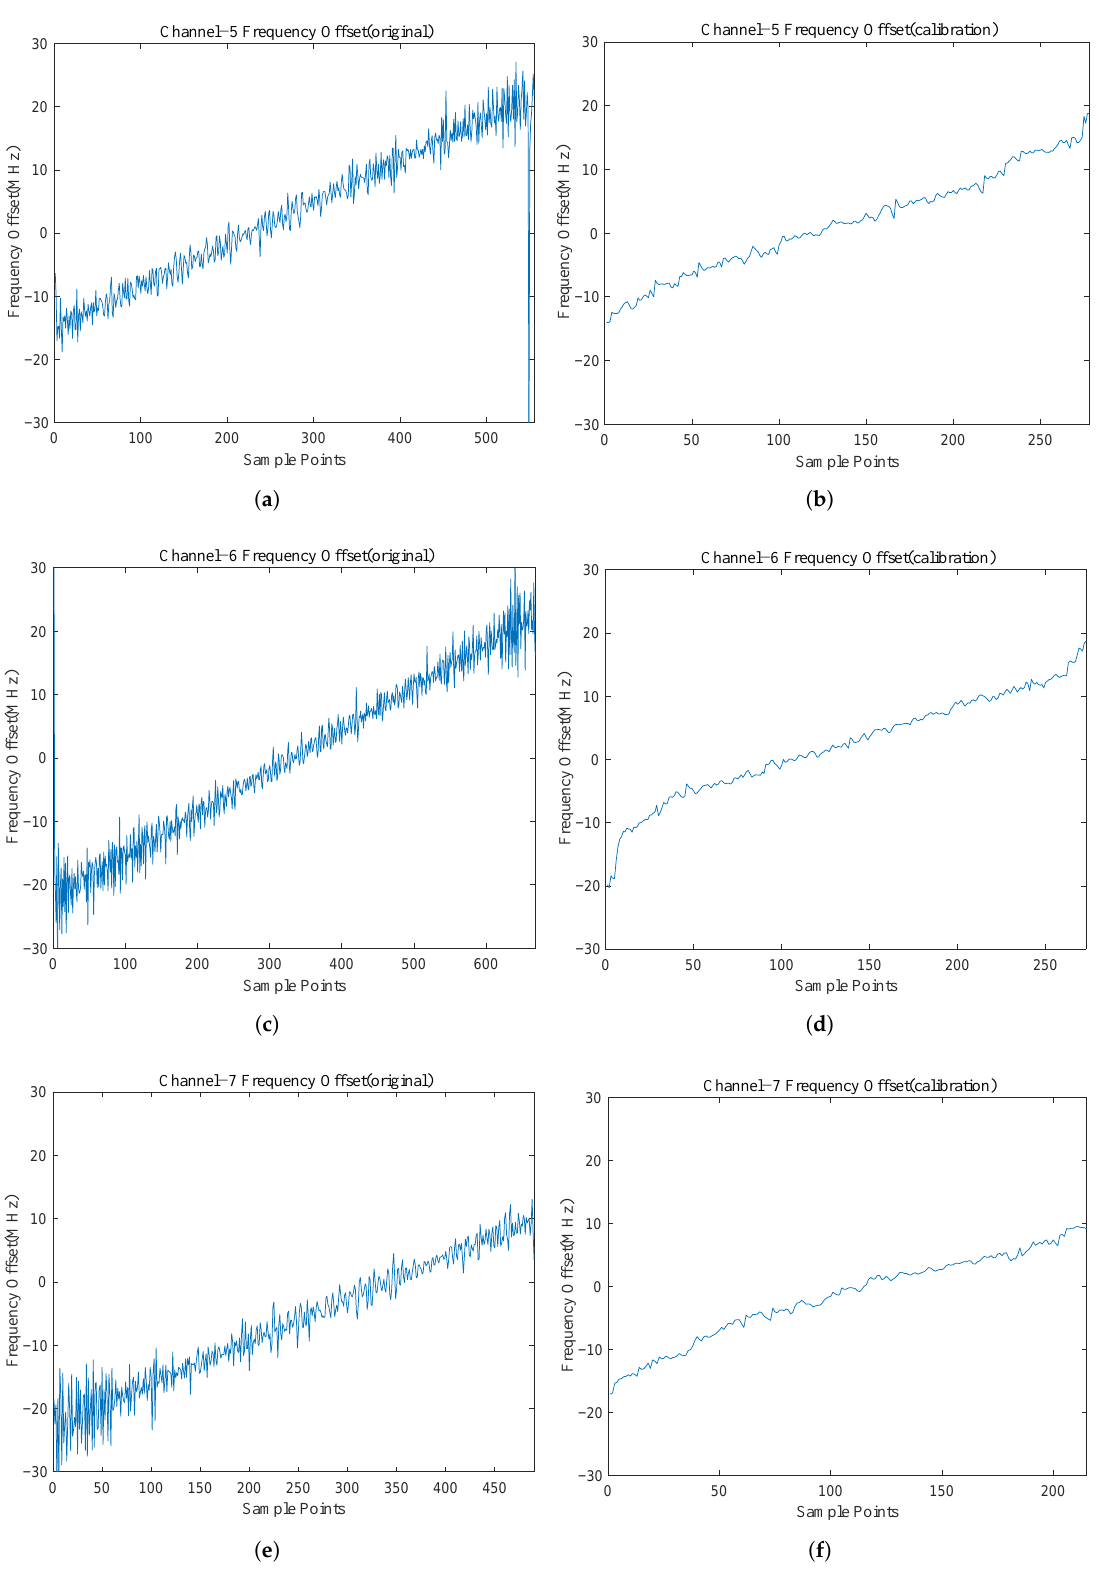
Figure 10. The IFM results of the correct Channel 5, 6, and 7: ( a ) the original IFM result of Channel 5; ( b ) the calibrated IFM result of Channel 5; ( c ) the original IFM result of Channel 6; ( d ) the calibrated IFM result of Channel 6; ( e ) the original IFM result of Channel 7; ( f ) the calibrated IFM result of Channel